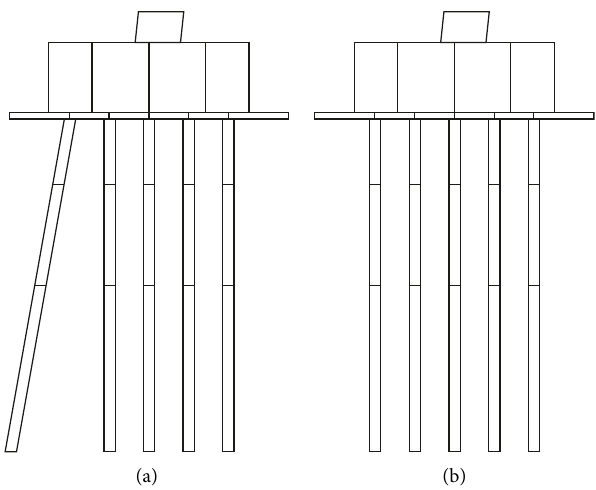
Figure 1: Facade plan of single cap: (a) left elevation; (b) front elevation.